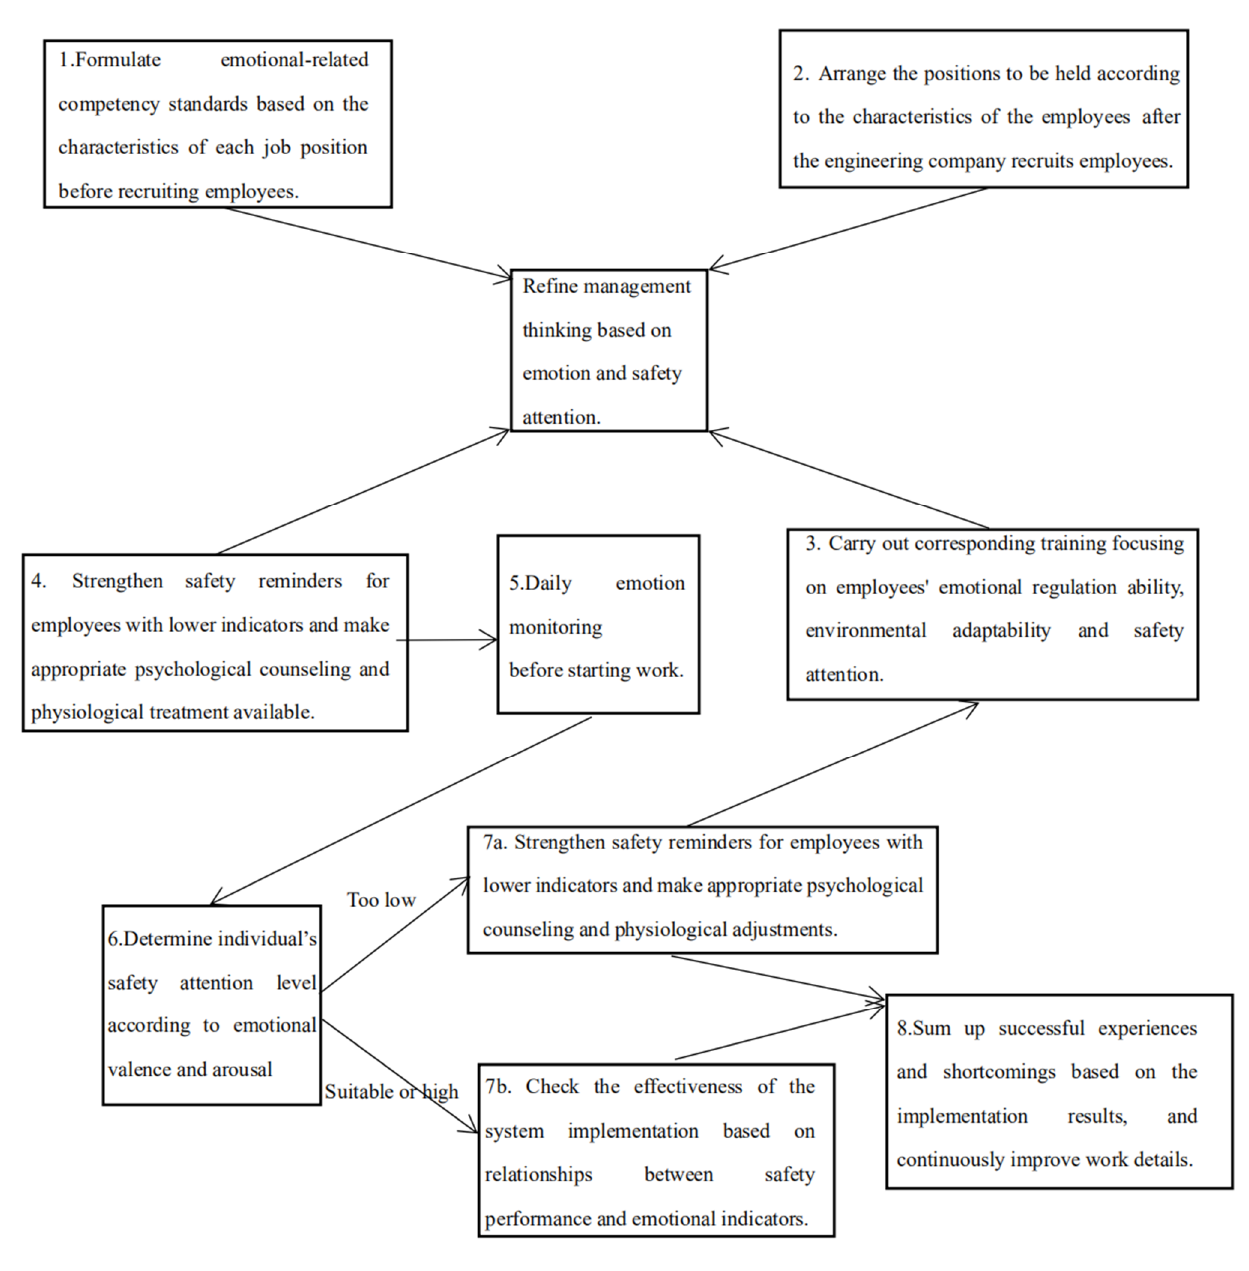
Figure 5. Refined management model based on emotion and safety attention.